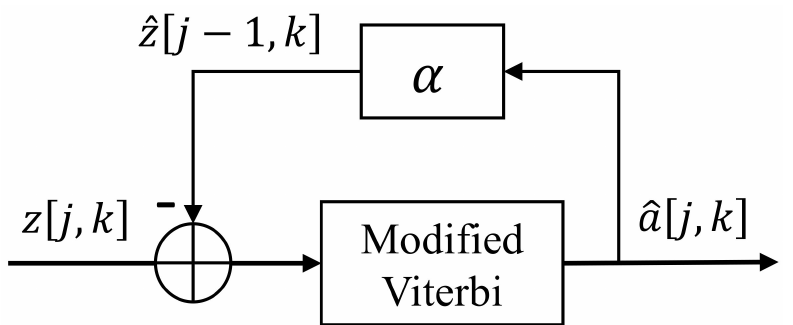
Figure 8. Our proposed method is summary as Algorithm 1. To easier visualization, we present Algorithm 1 in the Figure 9.